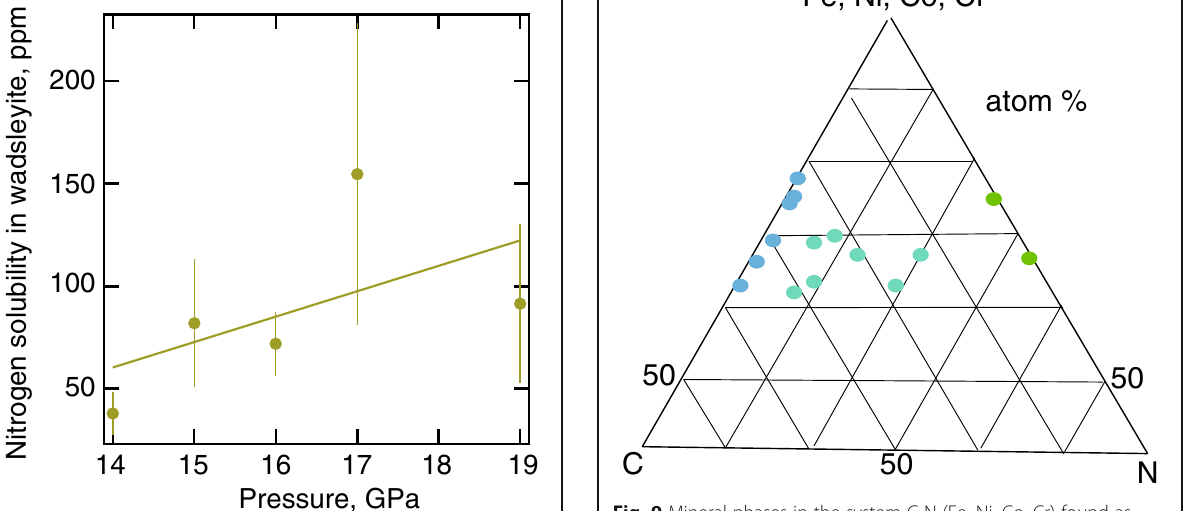
Fig. 9 Mineral phases in the system C-N-(Fe, Ni, Co, Cr) found as inclusions in lower mantle diamonds (data from Kaminsky and Wirth